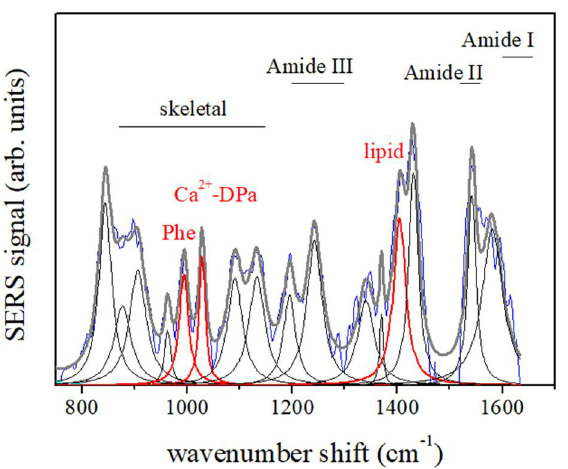
Figure 4. SERS response of spores P. thermantarcticus. This spectrum was obtained by averaging SERS spectra measured at different positions of the sample. The Lorentzian components have been determined by a fitting procedure to individuate the main modes occurring in the signal. The experimental spectrum (blue line) is compared with the fit result (grey thick line) obtained by considering the different mode components (black lines). The modes assigned to phenylalanine, Ca 2+ -DPA, and lipid contributions are reported in red.